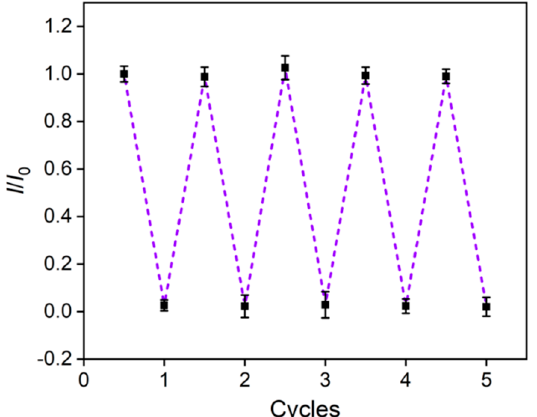
Figure 8. The relative peak current ratio obtained in the original or reproduced sensor. The above five points were obtained in TR solution and the bottom five points were produced in the supporting PBS electrolyte.